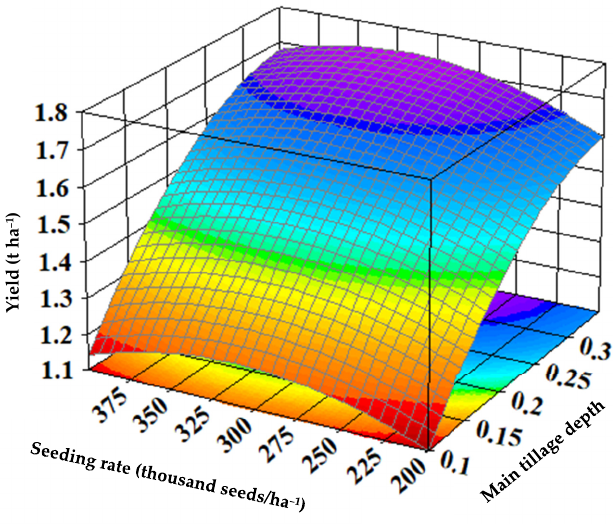
Figure 4. Response surface graph for the dependence of the yield of Alexandrite safflower cultivar on seeding rate and tillage treatment.